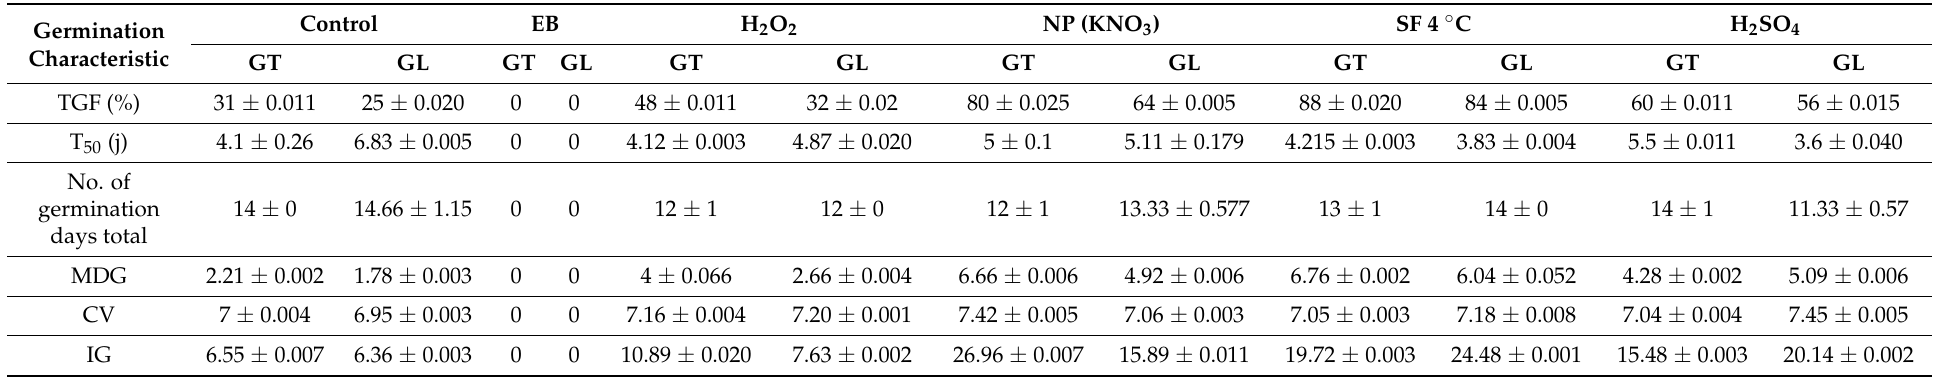
Table 3. Averages of the main germination parameters of A.P var. pyrethrum seeds (GL: peripheral seeds; GT: central seeds) on filter paper, according to the different